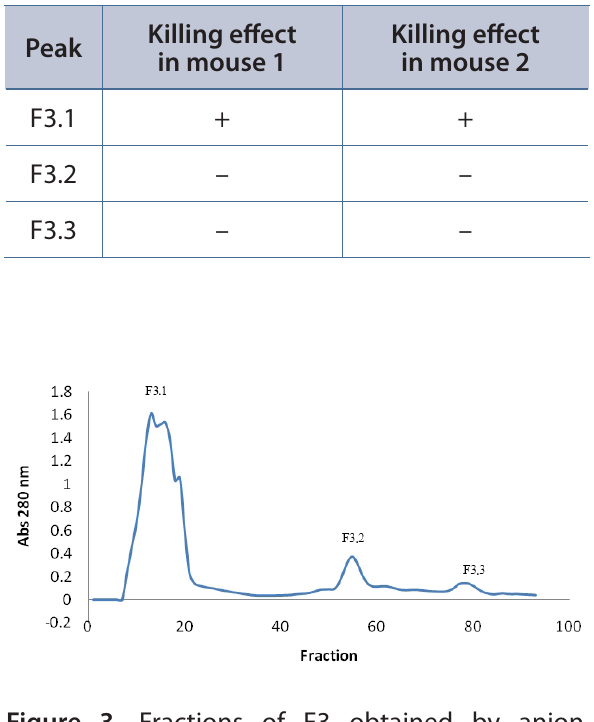
Figure 3. Fractions of F3 obtained by anion- exchange chromatography with DEAE